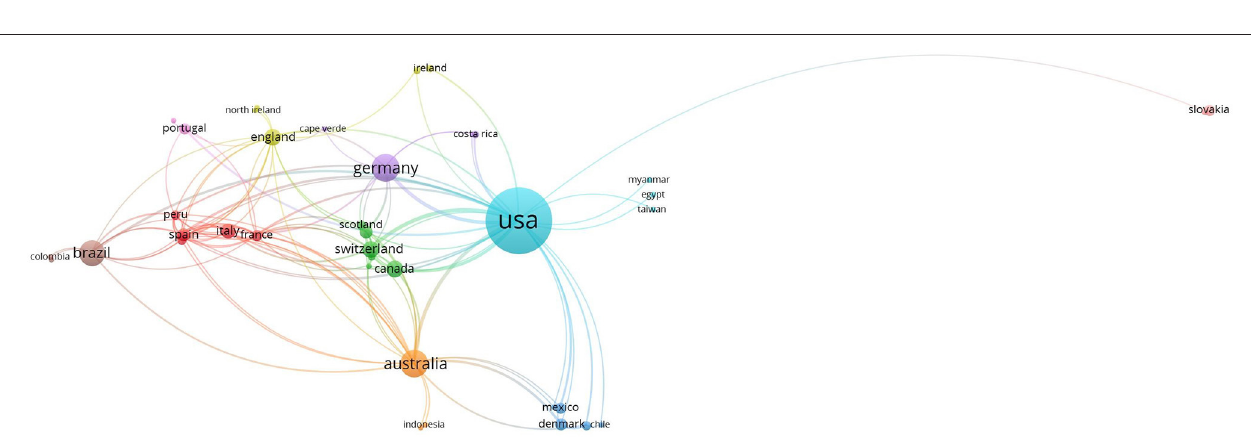
FIGURE 4 | Links between collaborating authors from different countries with research output from inception to 2020. The circular coloured nodes represent countries and the node size indicates number of publications from the country. The lines between nodes indicate authorship collaborations between countries and the widths of these lines indicate the link